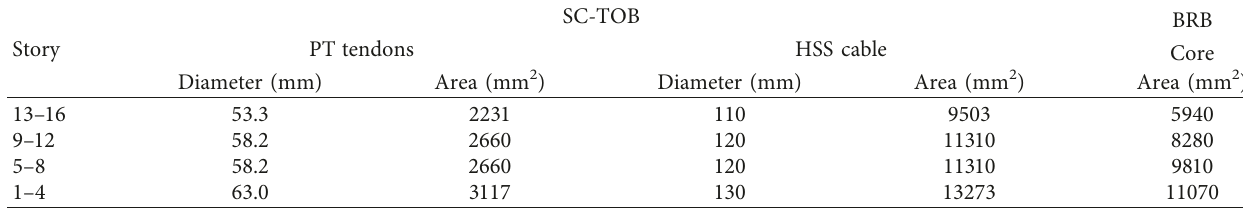
Table 6: Geometric detail of braces of the 16-story frames.